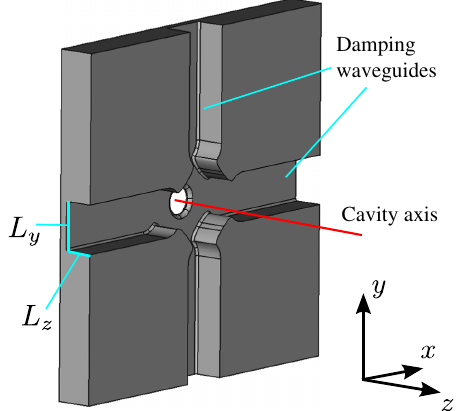
FIG. 1. In the above CLIC accelerating cell, [25] the four radial rectangular waveguides (terminated by electromagnetic absorb- ers) strongly damp HOMs; the cutoff frequency of each wave- guide is slightly above the accelerating mode frequency and well below the lowest dipole